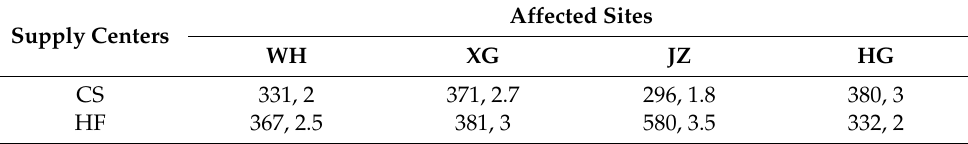
Table 4. Shortest distance and fixed transportation cost from supply center to affected site.